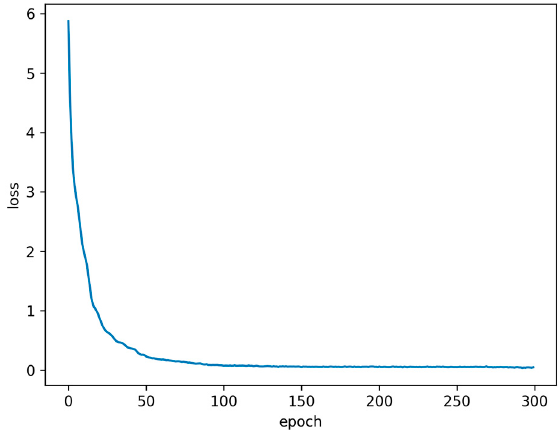
Figure 14. CNN-LSTM network mean square error loss function curve.